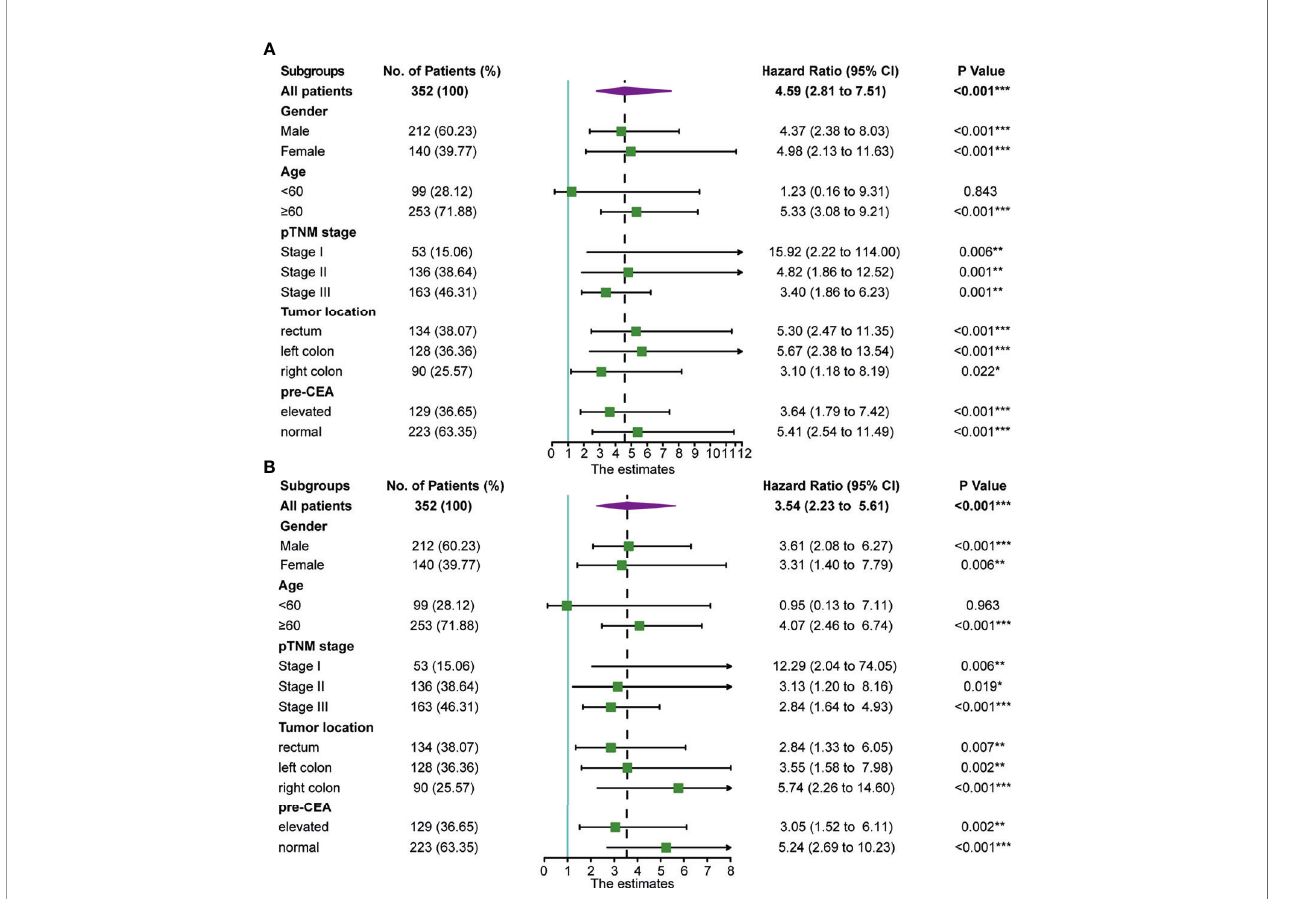
FIGURE 2 | Association of postoperative carcinoembryonic antigen (post-CEA) with (A) overall survival (OS) and (B) disease-free survival (DFS) in all patients and subgroups of patients with colorectal cancer (CRC) in the discovery cohort. Pre-CEA, preoperative carcinoembryonic antigen; CI, con fi dence interval. (*P < 0.05, **P < 0.01, ***P <